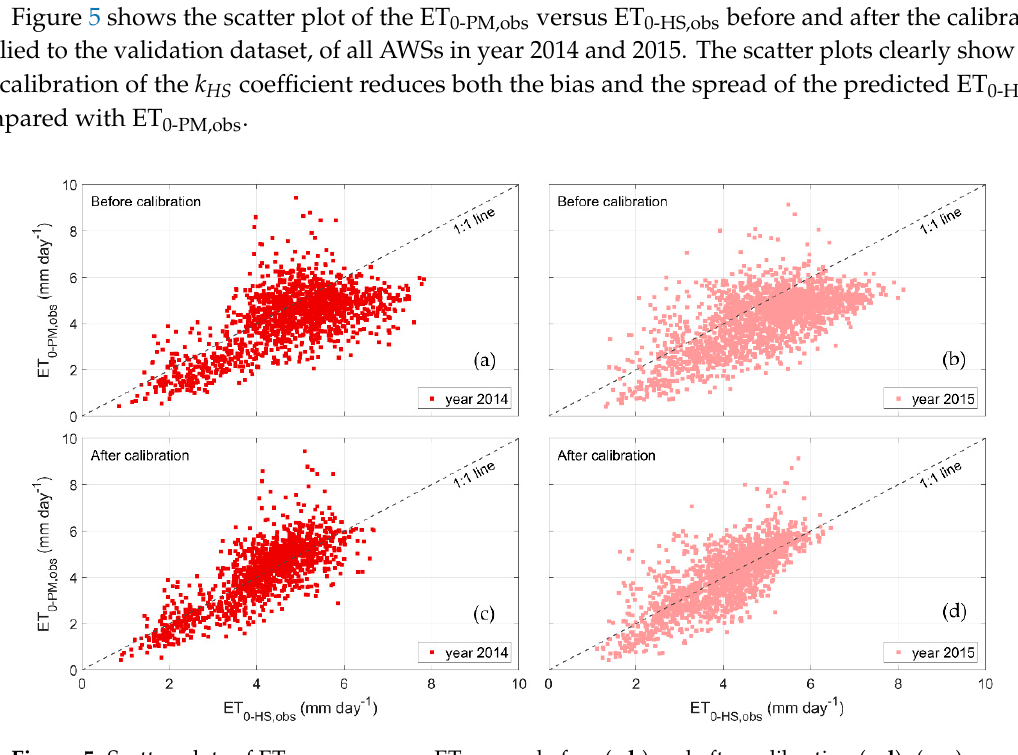
Table 2. Calibrated k HS values along with RMSE for the calibration (2010–2013) and validation (2014– 2015).